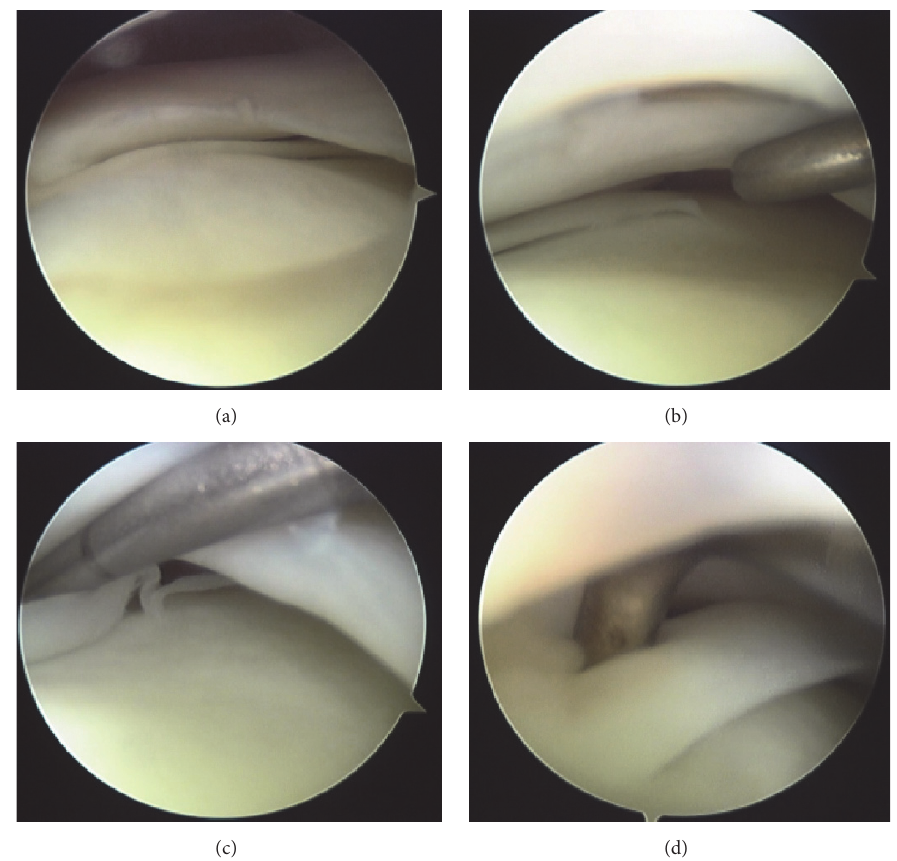
Figure 2: Arthroscopic findings. (a) Lateral meniscus of the left knee. (b) A second semicircular meniscus is seen under the original lateral meniscus. It could be pulled forward easily on probing (c, d).